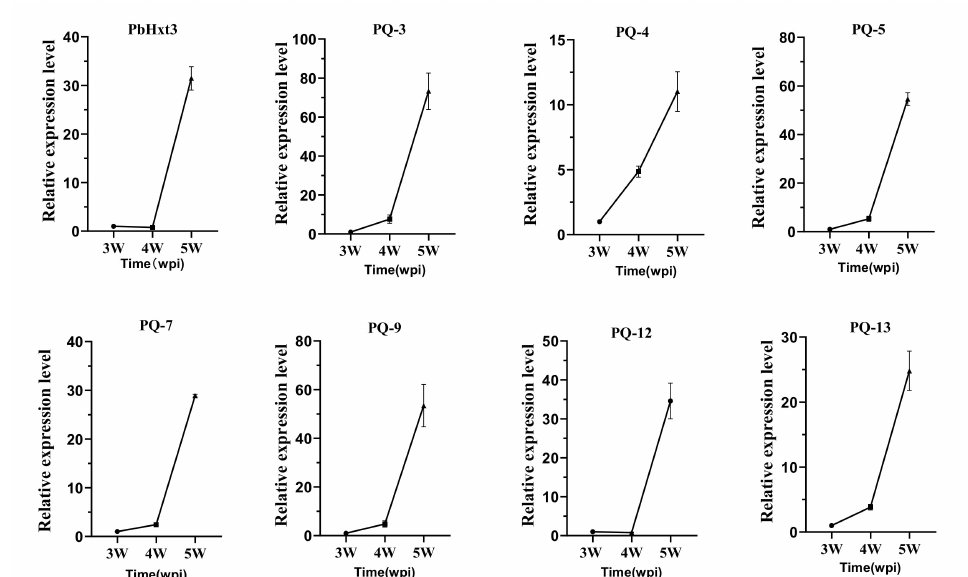
Figure 5. Relative expression level of glucose transporter genes in P. brassicae . qRT-PCR was used to quantify gene expression in cabbage roots at 3, 4, and 5 weeks post-inoculation (wpi) with P. brassicae . Transcript levels were normalized to the Pbactin gene. Three biological replicates were analyzed, and three technical repeats were performed per sample. Error bars indicate the standard errors between three biological repeats. Horizontal axis is time point from 3 to 5 weeks post-inoculation